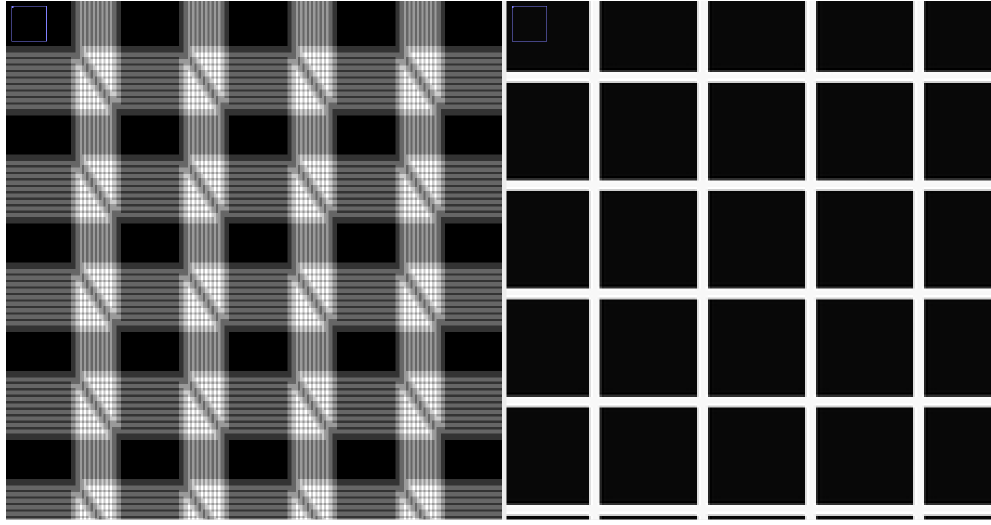
Figure 2. Phantom movie (grid, detail), an average of 10 frames, n th frame shifted by the vector [ 2 n ,3 n ] , before global alignment ( left ), after global alignment ( right